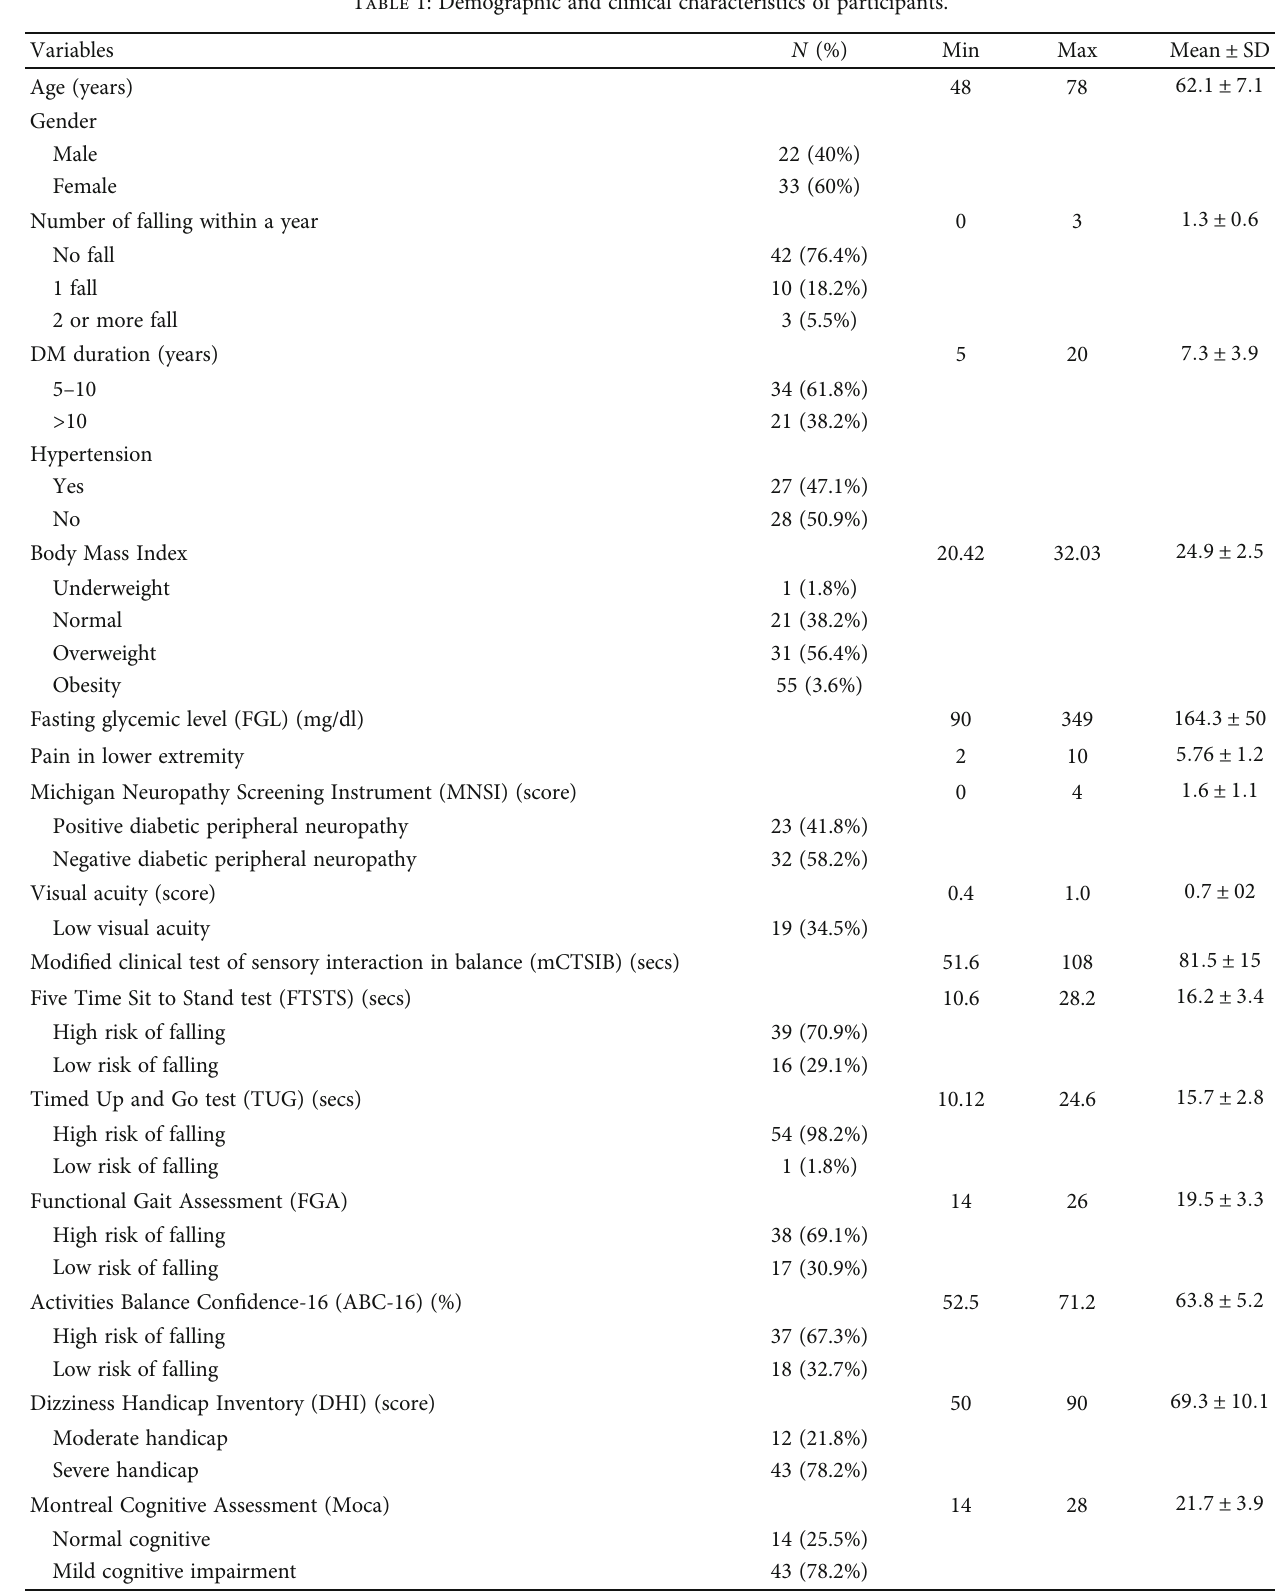
Table 1: Demographic and clinical characteristics of